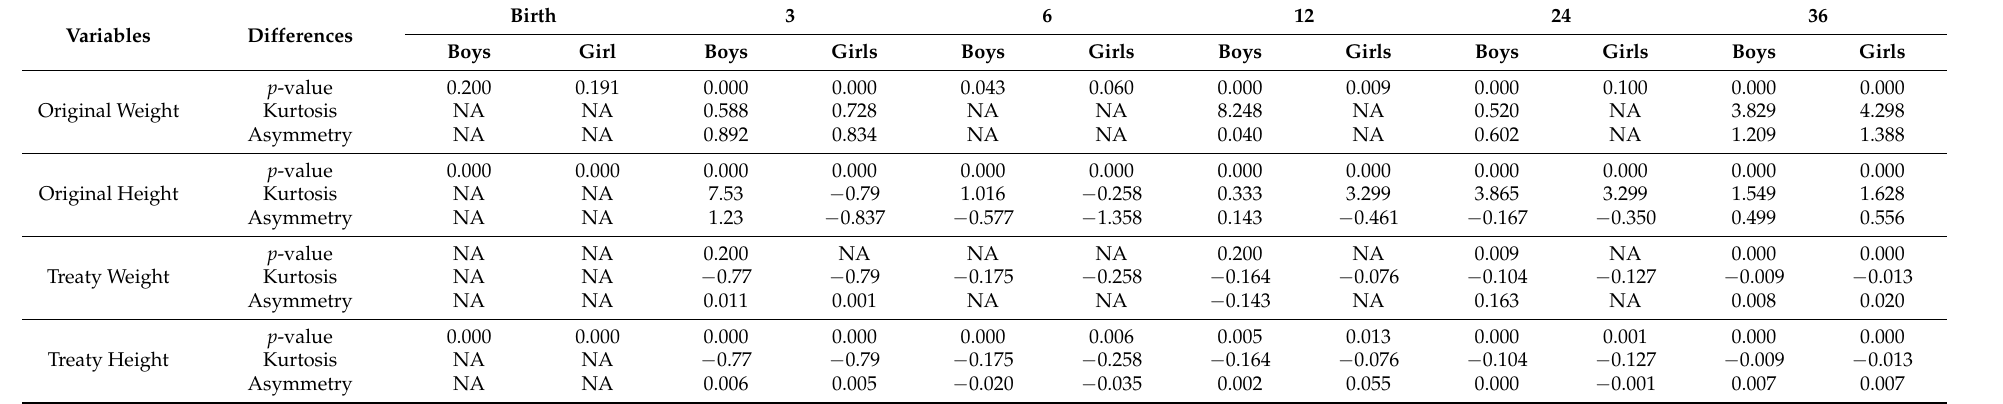
Table 1. Differences in kurtosis, asymmetry of weight and height from birth to 3 years of age after the two-step transformation process.